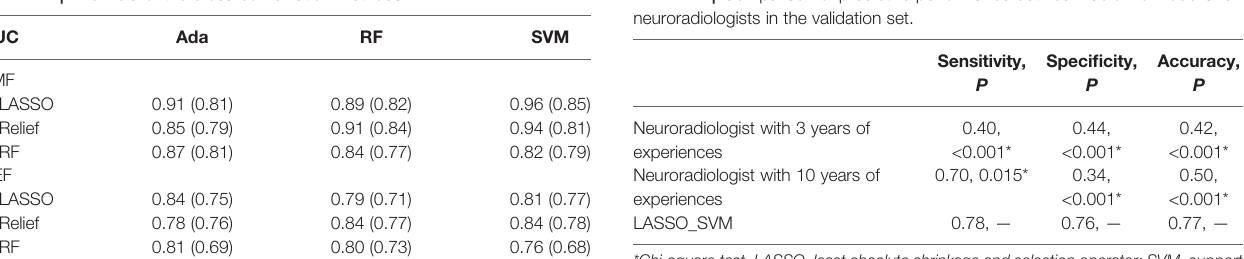
TABLE 2 | The AUC of the cross-combination methods.